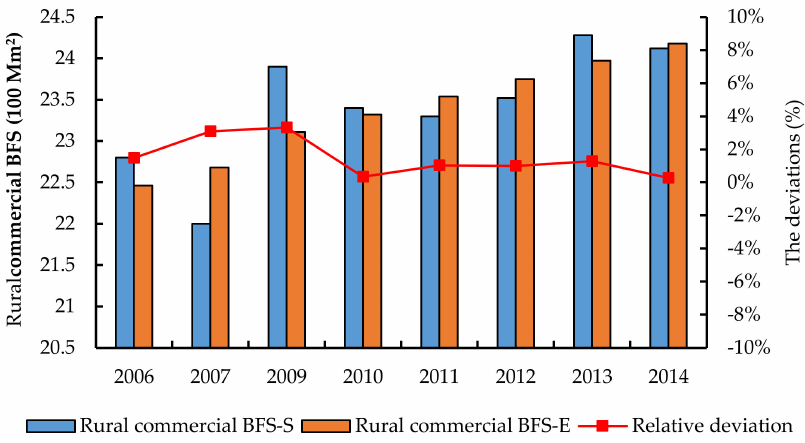
Figure 10. Comparison between the model results and the statistical data as for rural commercial floor space from 2006 to 2014 excluding